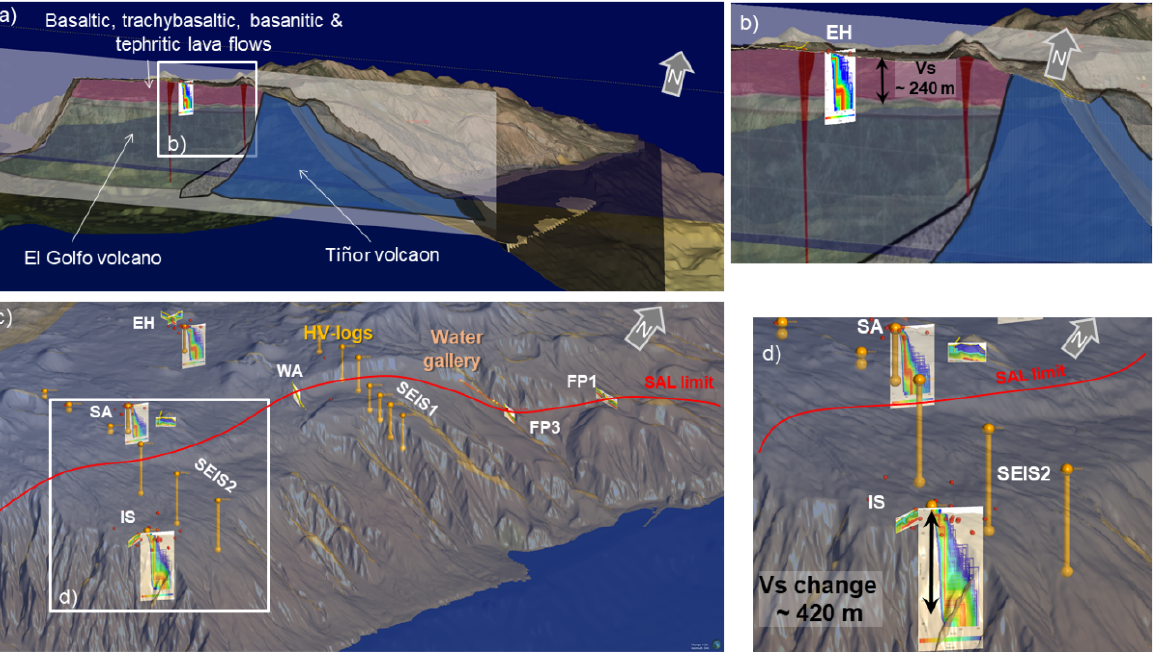
Figure 7. 3D geomodel of the studied El Hierro. ( a ) The central part of the SAL with inserted geological cross-section and geophysical results with the detailed view in the inset ( b ); ( c ) view of the SW part of the San Andr é s landslide with the results of the geophysical measurements and detailed view in the inset ( d